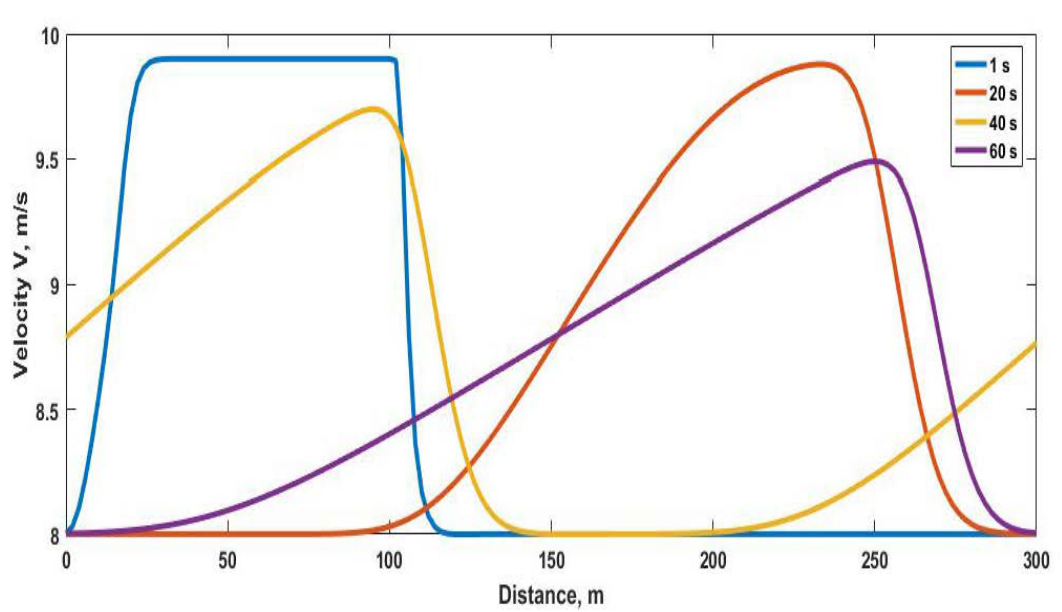
Figure 10. Velocity behavior with the proposed model for time step 0.01 s and road step 2 m on a 300 m circular road with h = 20 m at 1 s, 20 s, 40 s and 60